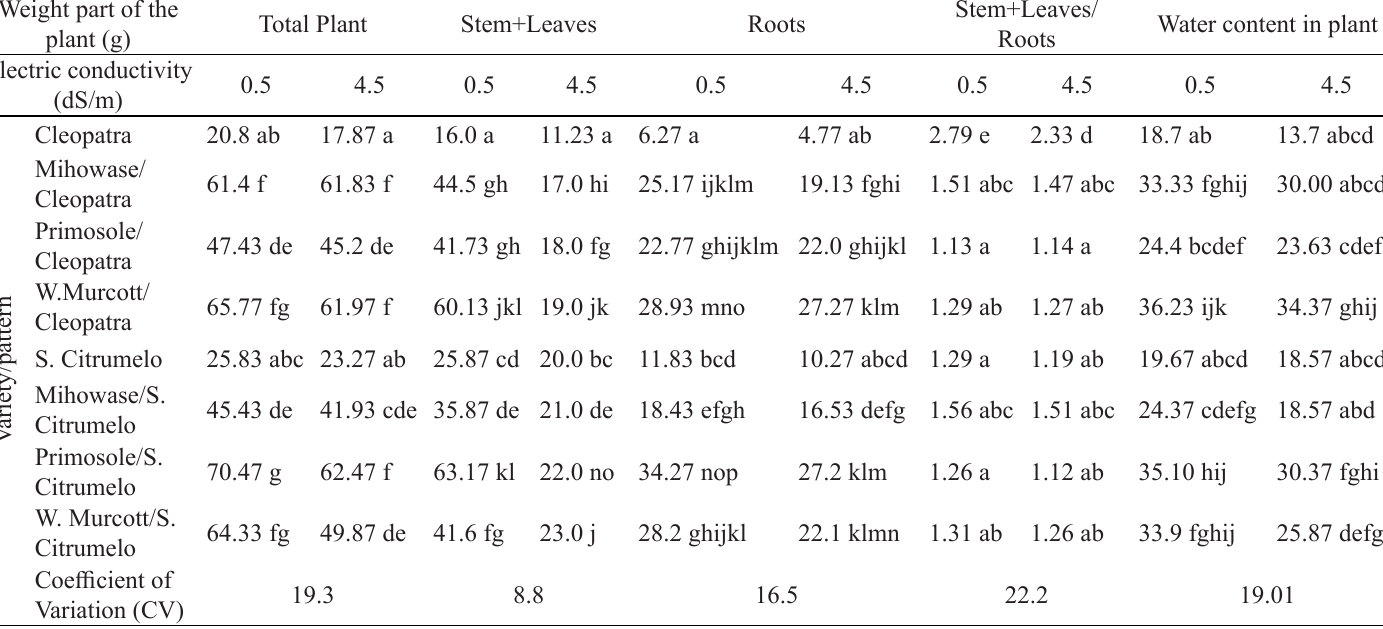
Table 2. Effects of salt stress on plant dry weight and plant water content for each scion/rootstock combination. Weight part of the Total Plant Stem+Leaves Roots plant (g)